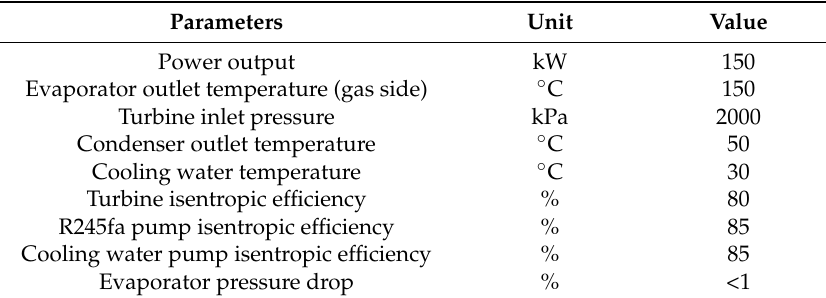
Table 6. Parameters of organic Rankine cycle for lumped